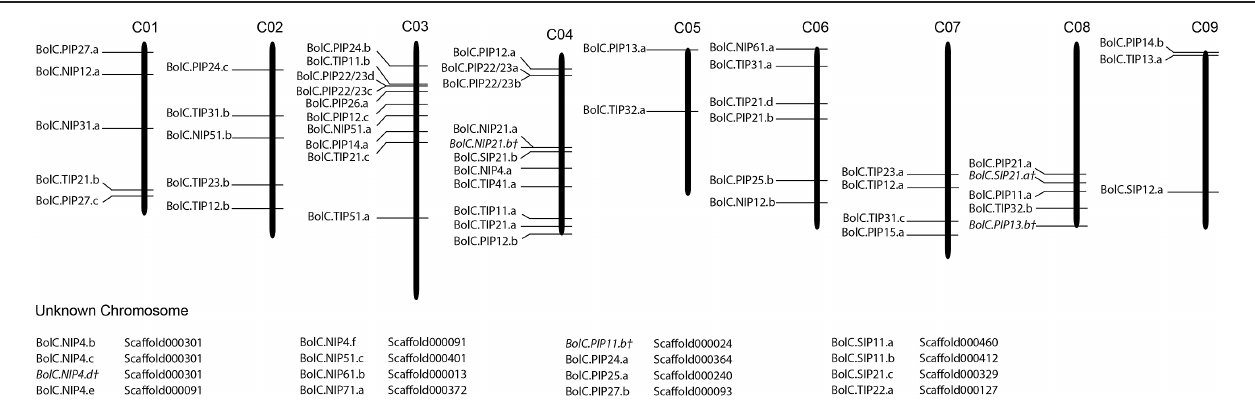
FIGURE 1 | Distribution of aquaporin genes on the nine Brassica oleraceae chromosomes. Sixteen genes could not be anchored onto a specific chromosome.